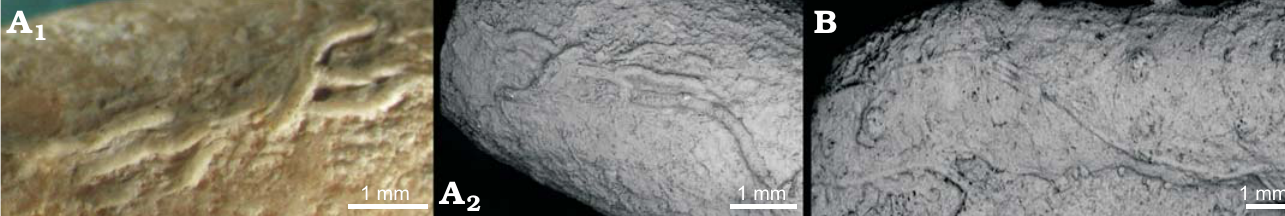
Fig. 3. Serpulid Filograna sp. from the Sosio Valley, western Sicily (Italy), Wordian to upper Permian. A . MSNC 4524, set of subparallel tubes on a sponge. Photograph (A 1 ), SEM image showing a Y bifurcation of a tube (A 2 ). B . MSNC 4525, slightly curved tubes on a